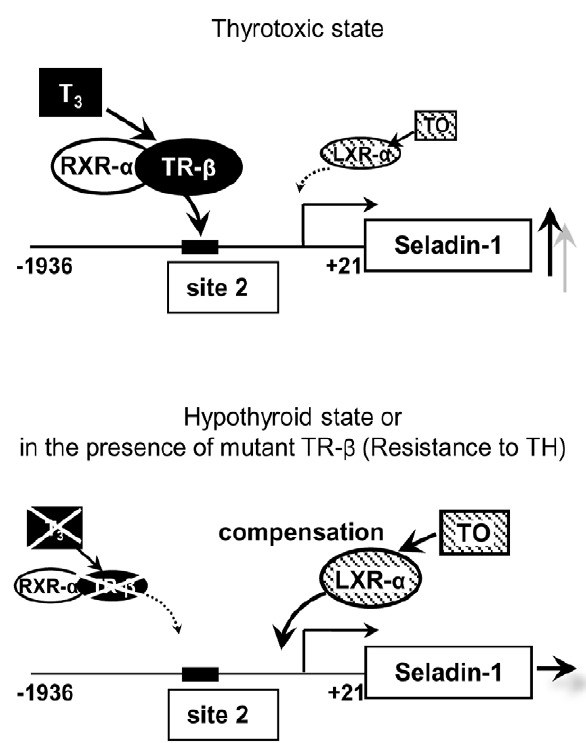
Figure 9. Schematic diagram illustrating the hypothetical mechanism of TR and LXR crosstalk on the mouse Seladin-1 gene promoter.